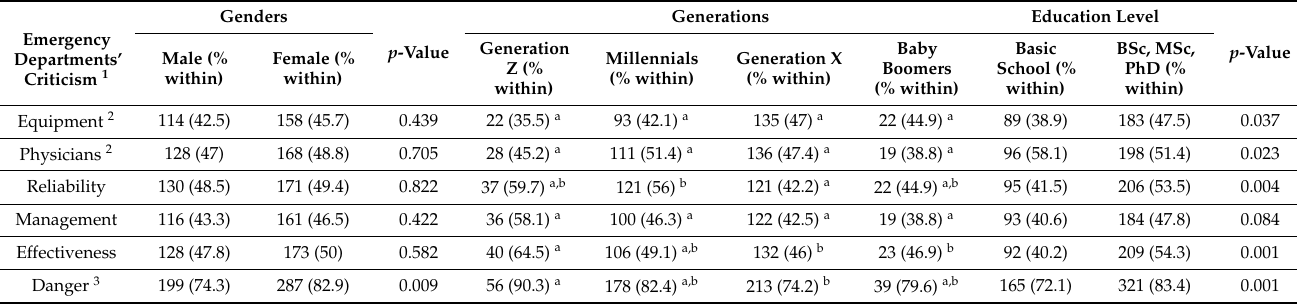
Table 3. Societal criticism for hospital EDs’ medical diagnosis parameters and issues, n =